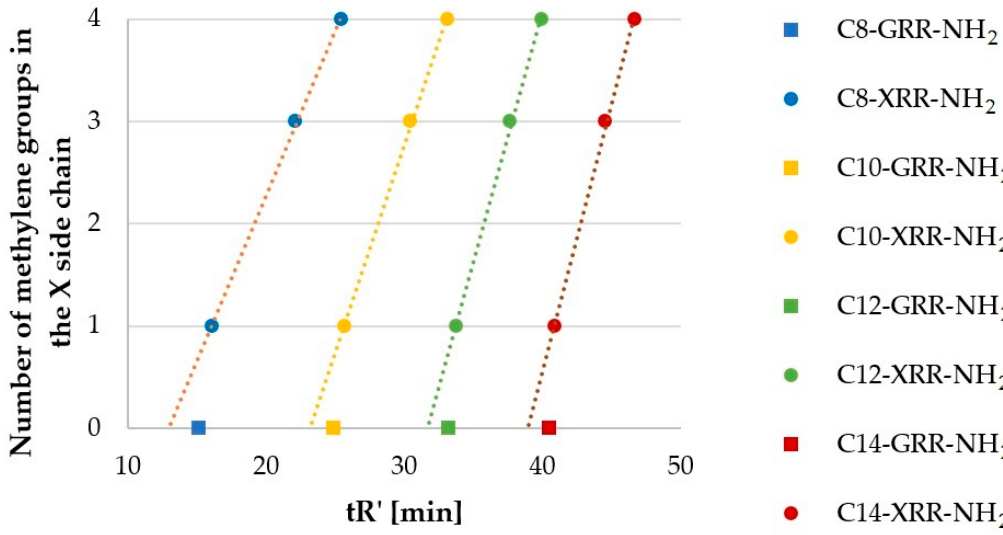
Figure 3. Hydrophobicity (tR’) of lipopeptides containing Gly ( 27 – 30 ), Ala ( 7 – 10 ), Nva ( 67 – 70 ), and Nle ( 63 – 66 ) versus number of methylene groups in the side chain.